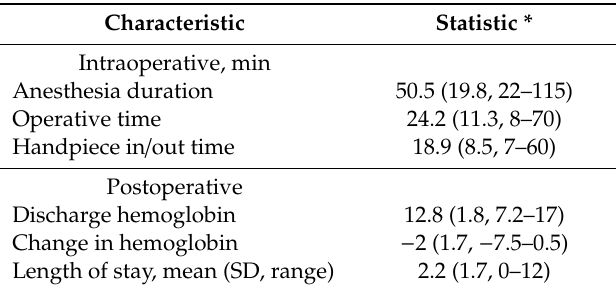
Table 2. Operative characteristics.